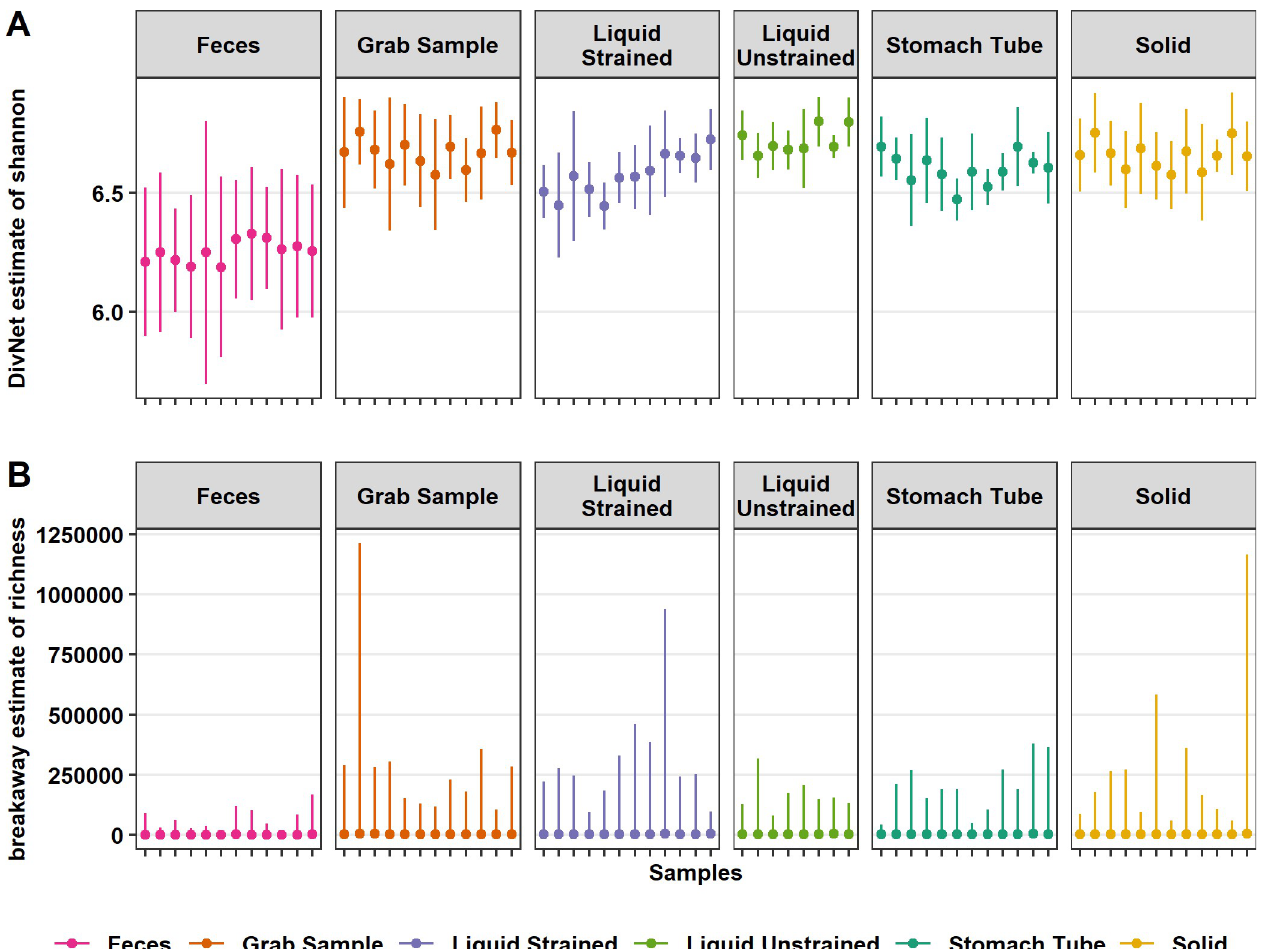
Fig 2. Differences in estimated alpha diversity among sample types. (A) DivNet estimate of Shannon diversity plotted as mean with 95% confidence intervals and (B) mean breakaway estimate of species richness with 95% confidence intervals. The x-axis ticks represent samples from each cow on different days. Both the richness and evenness of fecal samples were lower than all other rumen sample types ( P � 0.001). Stomach tube and liquid strained samples had lower evenness than grab samples ( P � 0.001). Solid and stomach tube samples were estimated to have fewer species than grab samples ( P = 0.02 and P � 0.001,